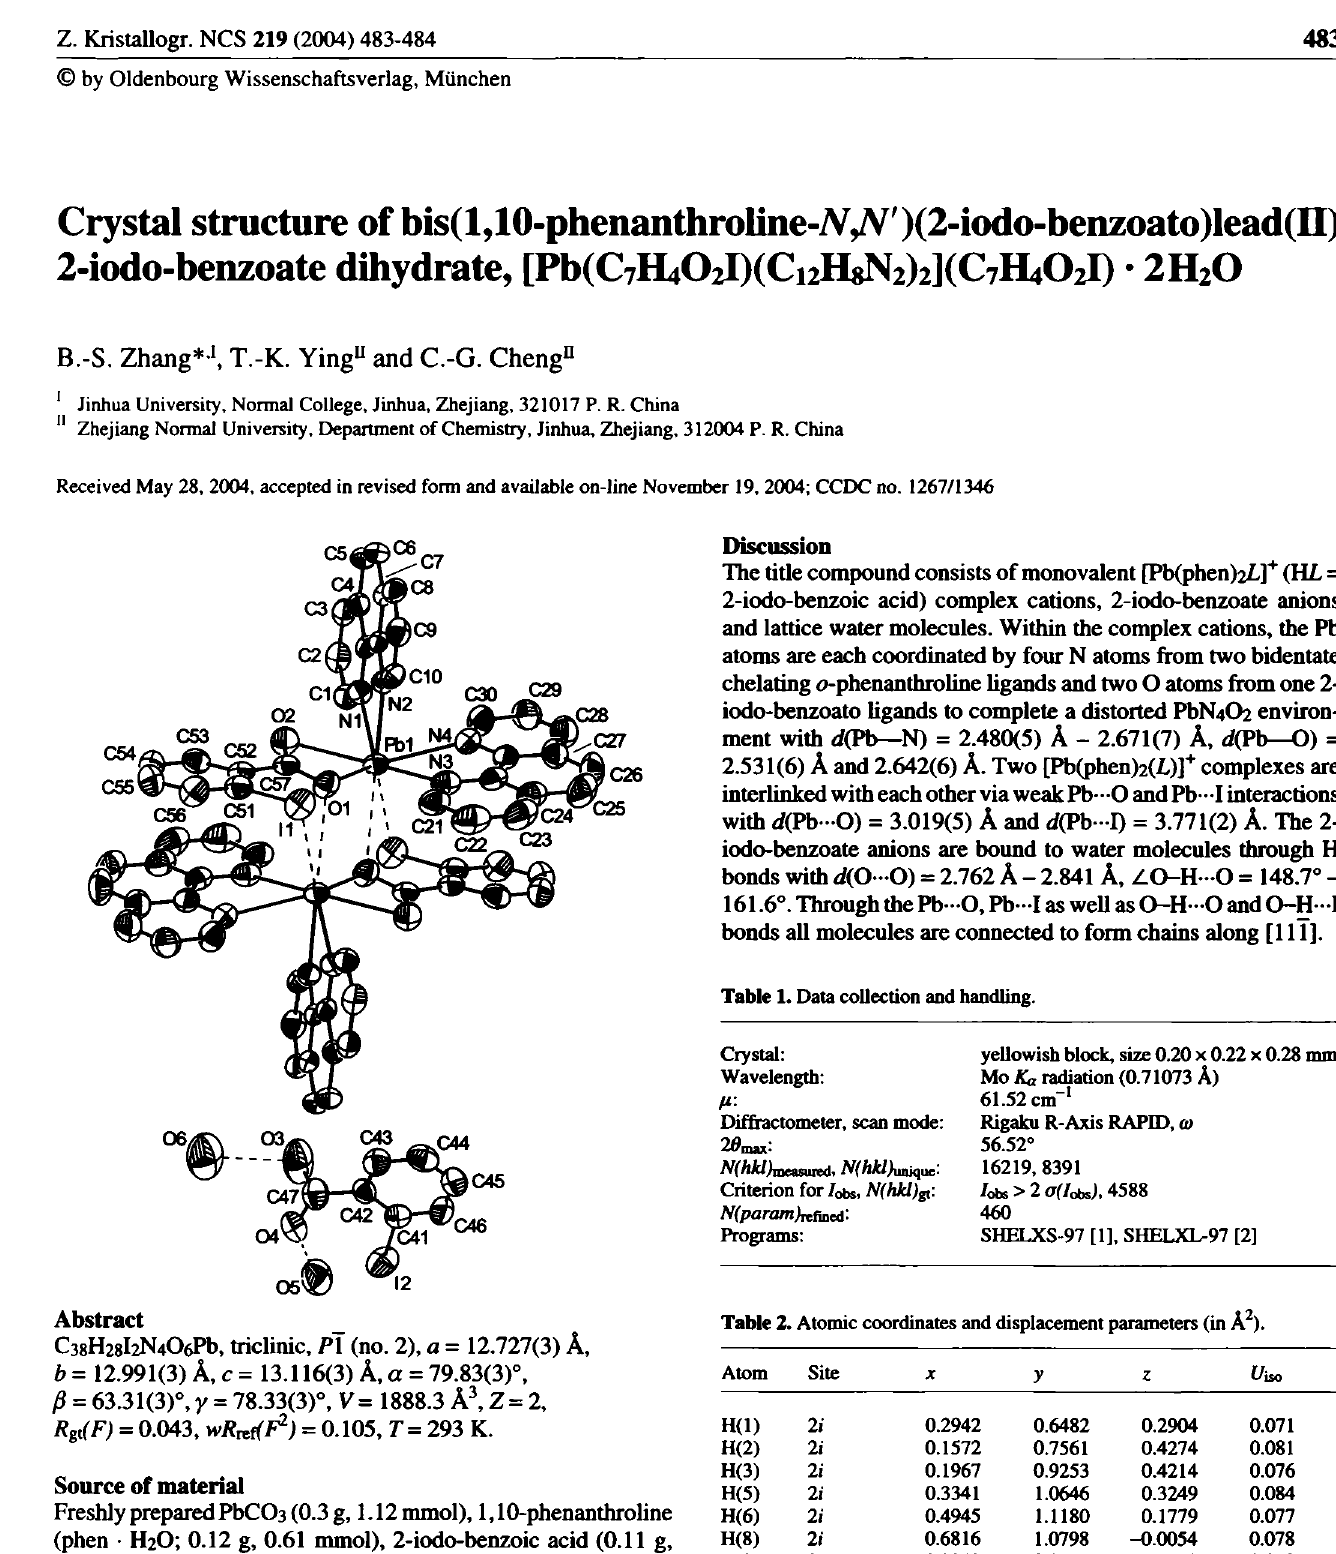
Table 2. Atomic coordinates and displacement parameters (in A 2